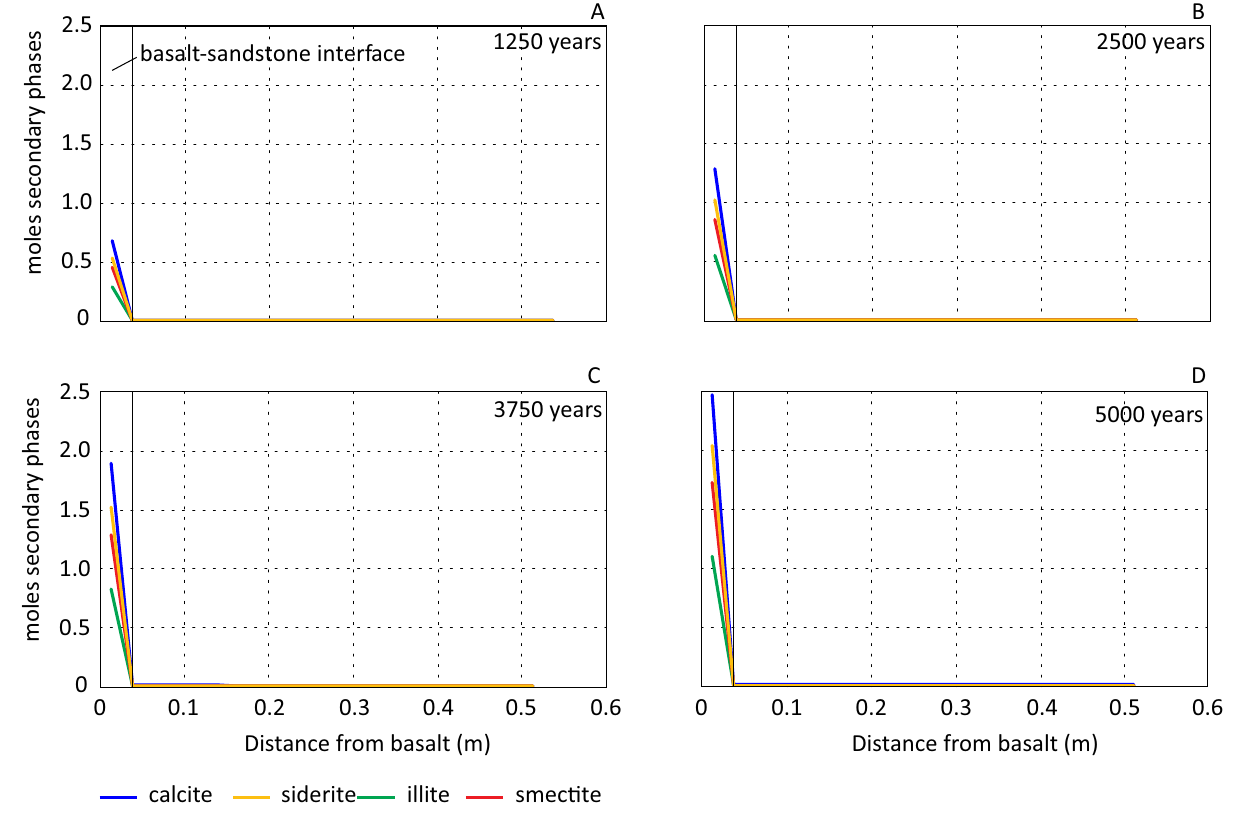
Figure 8. Change in moles of secondary minerals with distance from the basalt-sandstone interface after 1250, 2500, 3750 and 5000 years.